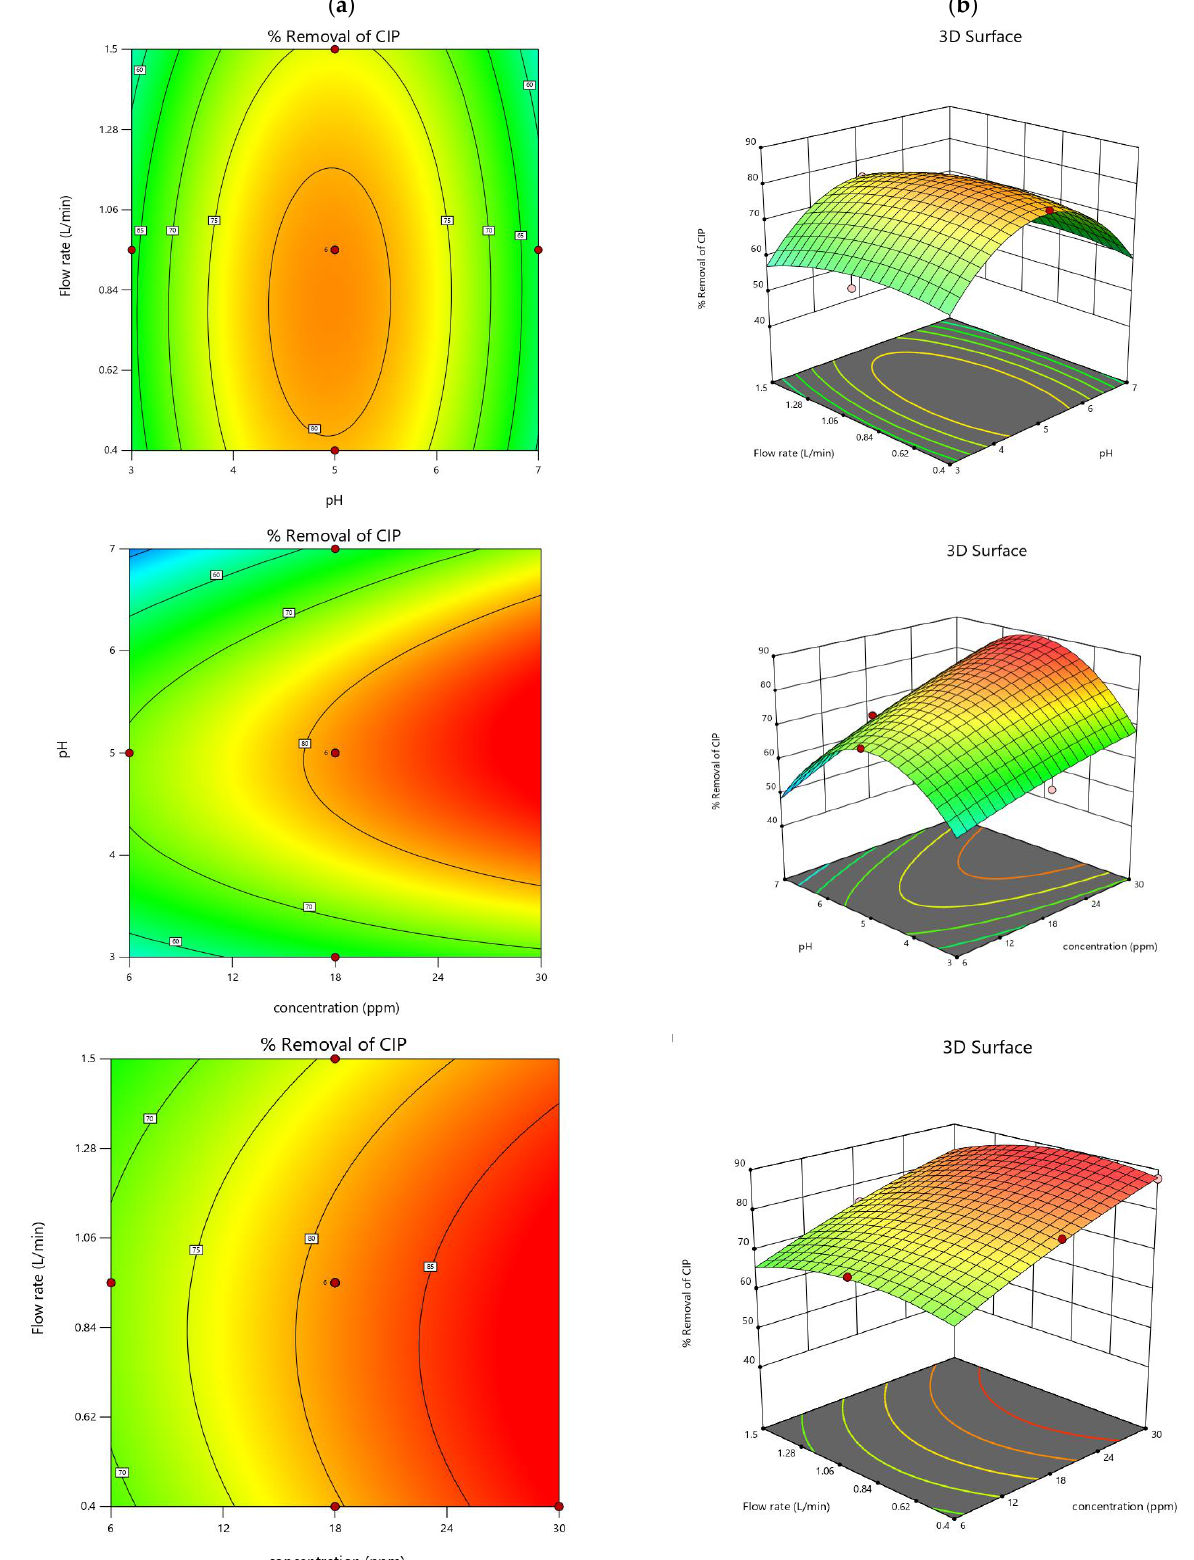
Figure 12. Interactive effects of pH, initial concentration, and flow rate on the removal efficiency of CIP: ( a ) Two-dimensional (2D) response surface perimeters. ( b ) Three-dimensional (3D) response surface